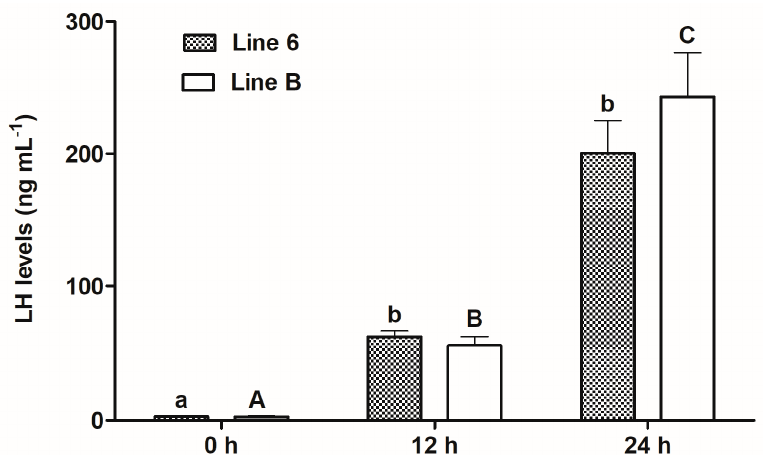
Figure 1. Plasma LH levels in blood samples taken from females from two breeding lines of common carp, i.e., Polish line 6 ( n = 15) and Lithuanian line B ( n = 13) before the first injection of Ovopel (0 h), 12 h after this injection, i.e., at the time of the second injection of Ovopel (12 h) and 24 h after the first injection of Ovopel (i.e., 12 h after the second injection) (24 h). Different lowercase letters indicate significant differences between sampling times within line 6. Different uppercase letters indicate significant differences between sampling times within line B ( p ≤ 0.05). Differences between lines within sampling times were non-significant.